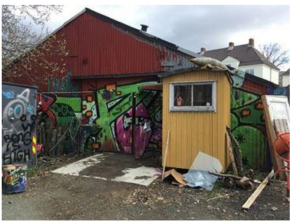
Figure 15. Workshop at Svartlamon (NTNU).